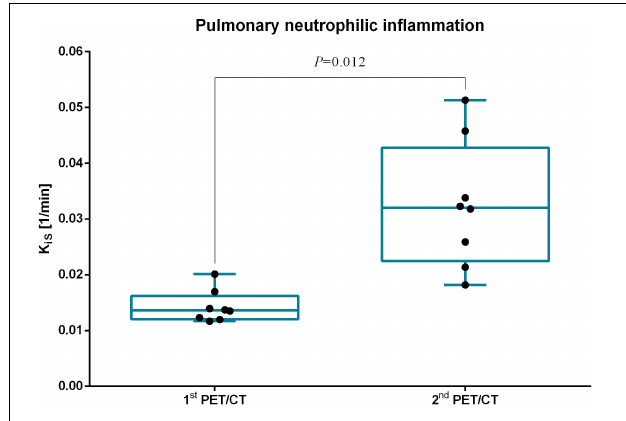
FIGURE 5 | Normalized 18 F-FDG uptake rate (K iS ) before and after intervention time. Normalized 18 F-FDG uptake rate (K iS ) before and after intervention time. PET/CT, positron-emission tomography; CT, computed